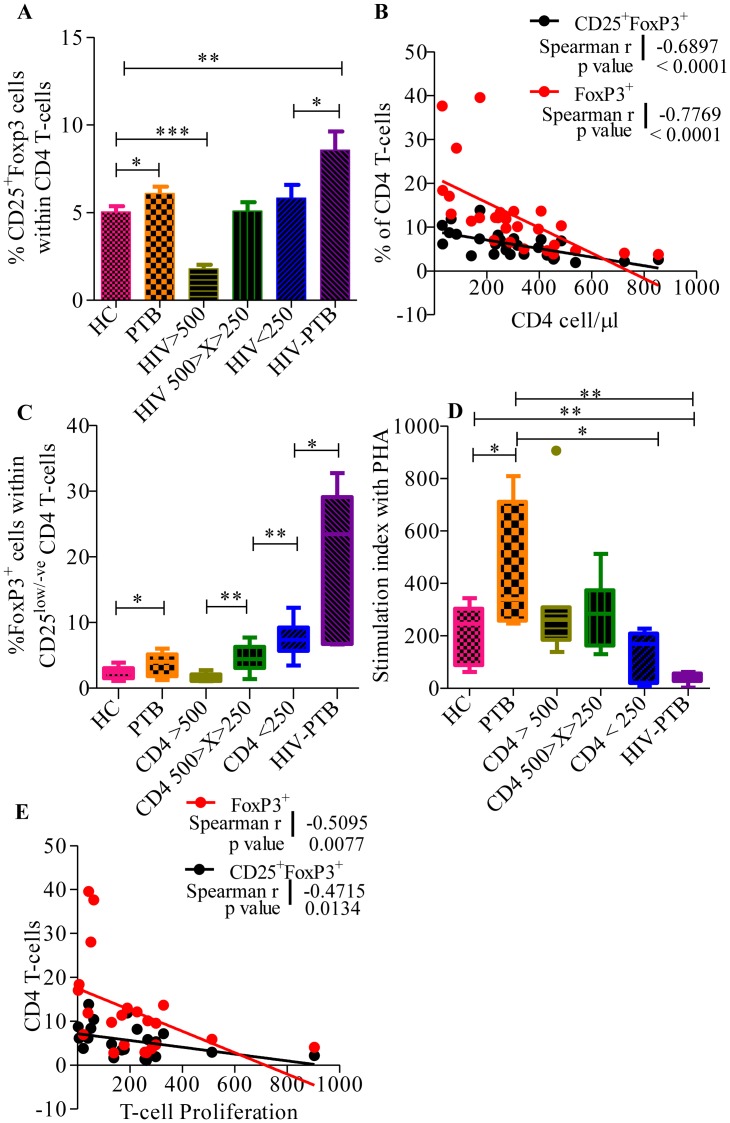
Higher Tregs frequency linked with PTB in individuals co-infected with or without HIV-1.
A. Cumulative data depicting frequency of CD25+Foxp3+ Tregs within CD4+ T-cell in healthy controls (HC), patients with Pulmonary tuberculosis (PTB) and HIV-1 infected individuals with or without PTB co-infection. B.
Association of increased Foxp3+ CD4 T-cell frequency with HIV-1 disease progression (decrease in CD4 count). Dot plot showing significant negative correlation between T-cell proliferation and CD4+Foxp3+ (red dots, Spearman r = −0.7769, p value <0.0001)/CD25+Foxp3+ (black dots, Spearman r = −0.6897, p value <0.0001) frequency in HIV-1 infected individuals. The solid line represents the linear regression of points and dotted lines represents 95% confidence band for their mean values. Rho and p values are from the Spearman rank correlation test. C.
Increase in the FoxP3+CD25low/-ve CD4 T-cells in PTB and HIV-PTB co-infected individuals. Whisker box plot showing frequency of FoxP3 positive cells within CD25low/-ve cells in the PBMCs of study subject groups. The horizontal line within the box indicates the median, the boundaries of the box indicate the 25th- and 75th -percentile, and the whiskers indicate the highest and lowest values of the frequency of FoxP3 positive cells. D.
Low T-cell proliferation in HIV-PTB co-infected individuals. Whisker box plot showing the proliferative T-cell response profile to PHA [stimulation for 96 hours] in PBMCs from healthy controls, patients with PTB and HIV-1 infected individuals with or without M. tuberculosis co-infection. Stimulation indices were determined by comparison with paired unstimulated cells from each individual. The horizontal line within the box indicates the median, the boundaries of the box indicate the 25th- and 75th -percentile, and the whiskers indicate the highest and lowest values of the stimulation indices. E.
Association of increased Foxp3+ CD4 T-cells frequency with decreased T-cell proliferative response. Dot plot showing significant negative correlation between T-cell proliferation and Foxp3+ (red dots, Spearman r = −0.5095, p value <0.0077)/CD25+Foxp3+ (black dots, Spearman r = −0.4715, p value  = 0.0134) in HIV-1 infected individuals. The solid line represents the linear regression of points and dotted lines represents 95% confidence band for their mean values. Rho and p values are from the Spearman rank correlation test.